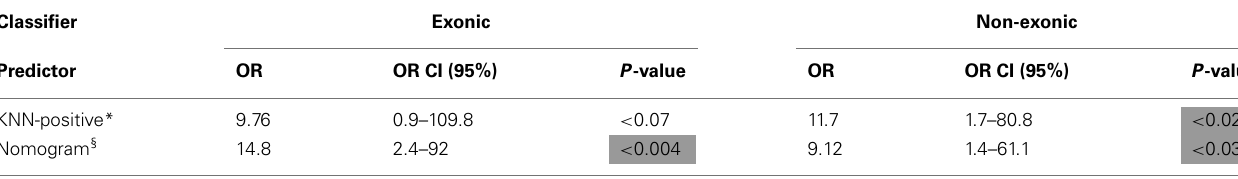
Table 4 | Multivariable logistic regression analysis for prediction of the probability of metastatic disease